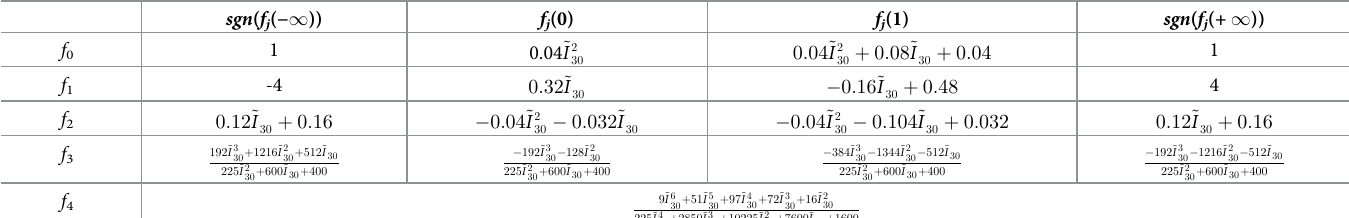
Table 1. Values of functions f j at certain points.